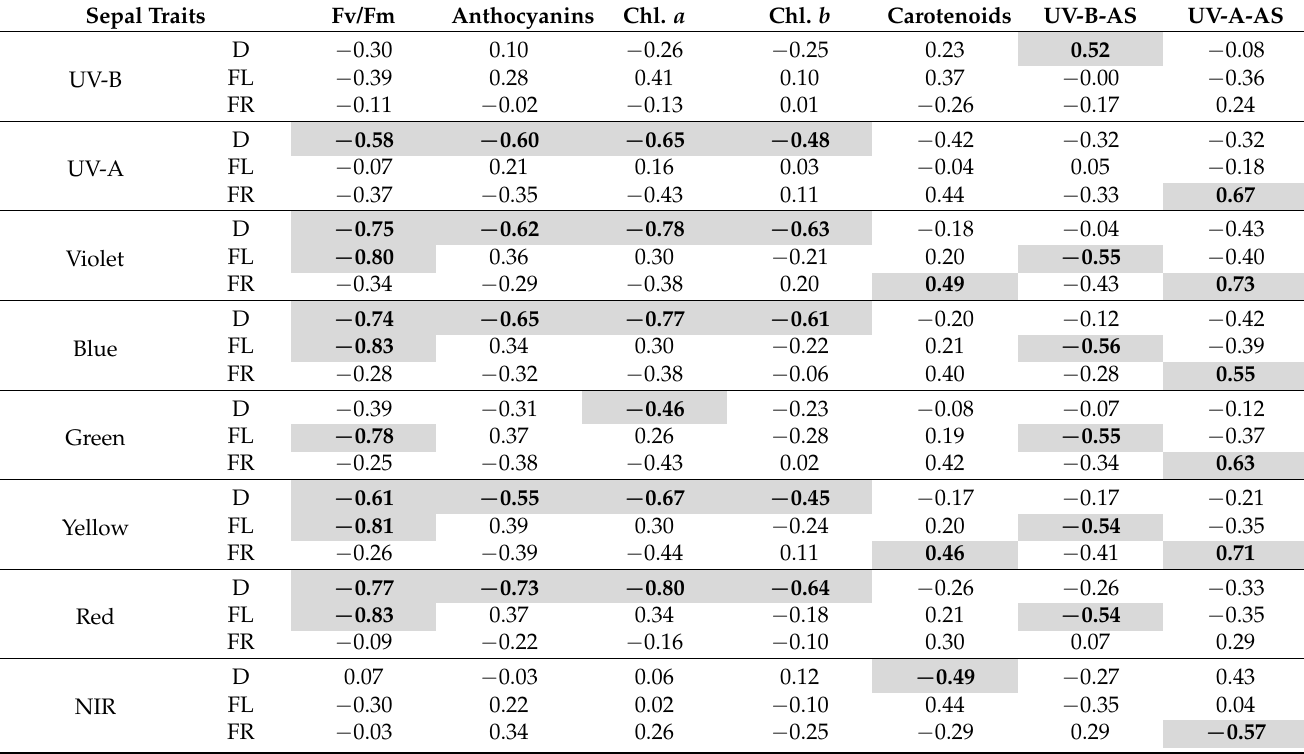
Table 3. Correlations between sepal transmittance in the different regions of the spectrum and some of the other measured H. niger and H. odorus sepal traits for each of the three different developmental phases. Significant correlations are indicated in bold ( p ≤ 0.05; Pearson’s